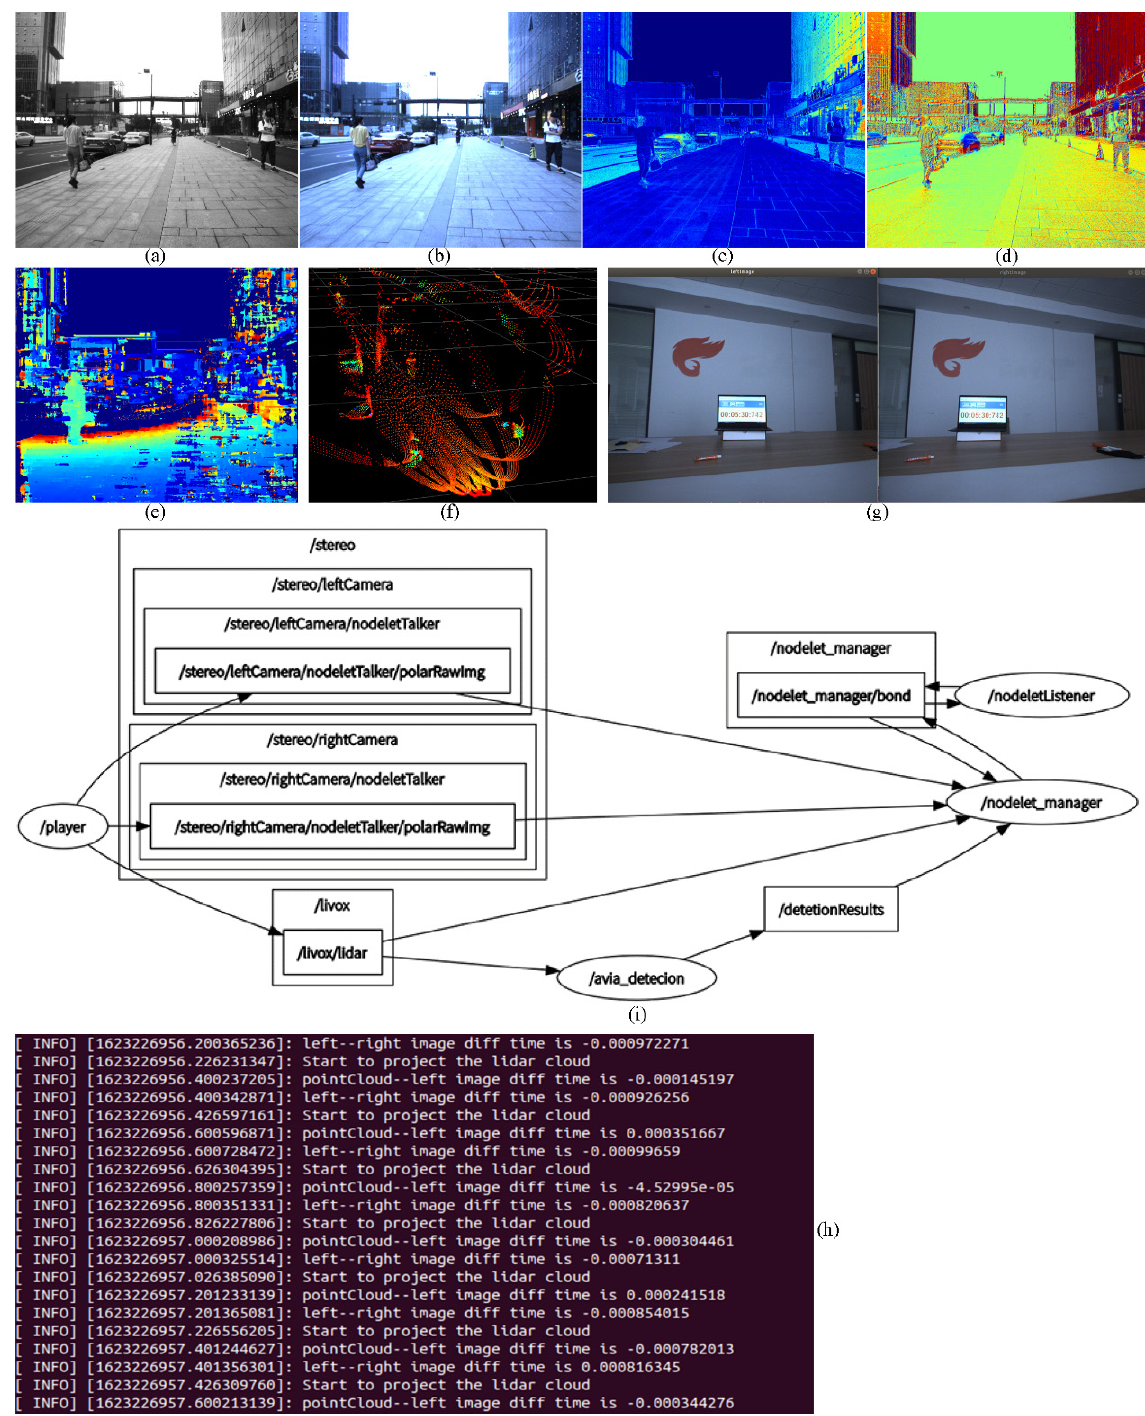
Figure 12. The data from multiple sensor and the synchronization accuracy of the hardware exper- imental platform: ( a ) the raw image of the left camera; ( b ) the color image with zero-degree polari- zation; ( c ) the normalization DoLP pseudo-color image (using opencv COLORMAP_JET); ( d ) the normalization AoLP pseudo-color image (using opencv COLORMAP_JET); ( e ) the stereo depth im- age, ( f ) the LiDAR point cloud; ( g ) the synchronization effect of the left and the right camera; ( h ) the synchronization effect of the left camera and the LiDAR, the unit is second; ( i ) the software frame- work of our data fusion system.